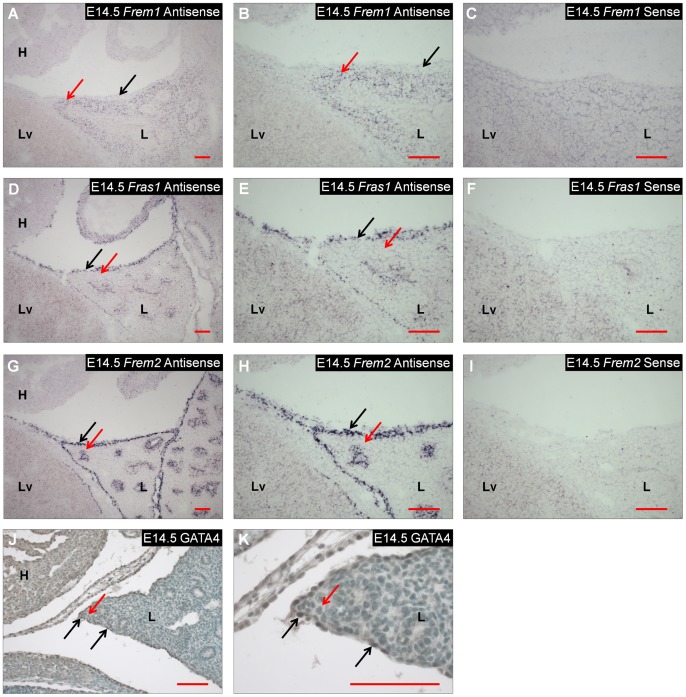

Frem1, Fras1, Frem2 and GATA4 are expressed in the developing lung at E14.5.A–I) The expression of Frem1, Fras1 and Frem2 was determined in sagittal sections from wild-type E14.5 embryos using in situ hybridization. In each case, a sense probe was used as a negative control. A–C) Expression of Frem1 is seen in the mesenchymal cells of the developing lung (red arrows) but is not detected in the mesothelial cells of the parietal pleura (black arrows). D–I) Fras1 (panels D–F) and Frem2 (panels G–I) are not expressed in the mesenchymal cells of the developing lung (red arrows) but are expressed in the upper, mesothelial cells of the parietal pleura (black arrows). J–K) GATA4 immunostaining on sagittal sections from wild-type E14.5 embryos showed no evidence of GATA4 nuclear staining in mesenchymal cells of the developing lung (red arrow) but strong nuclear staining in the mesothelial cells of the parietal pleura (black arrows). Red scale bar = 100 µm. H = heart; L = lung; Lv = Liver.